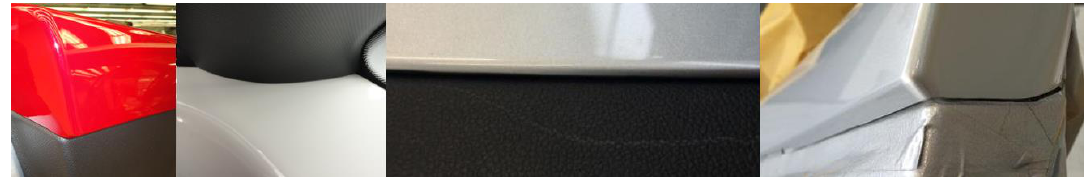
Figure 26. Painting with tape 3M with stiffened edges and masking tape.